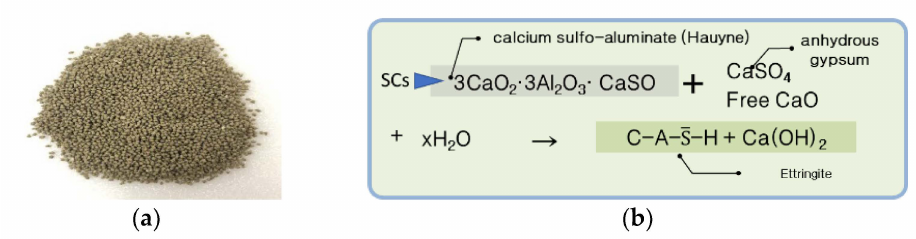
Figure 1. Solid capsules (SCs): ( a ) Sample of SCs. ( b ) Reaction mechanism of SCs.